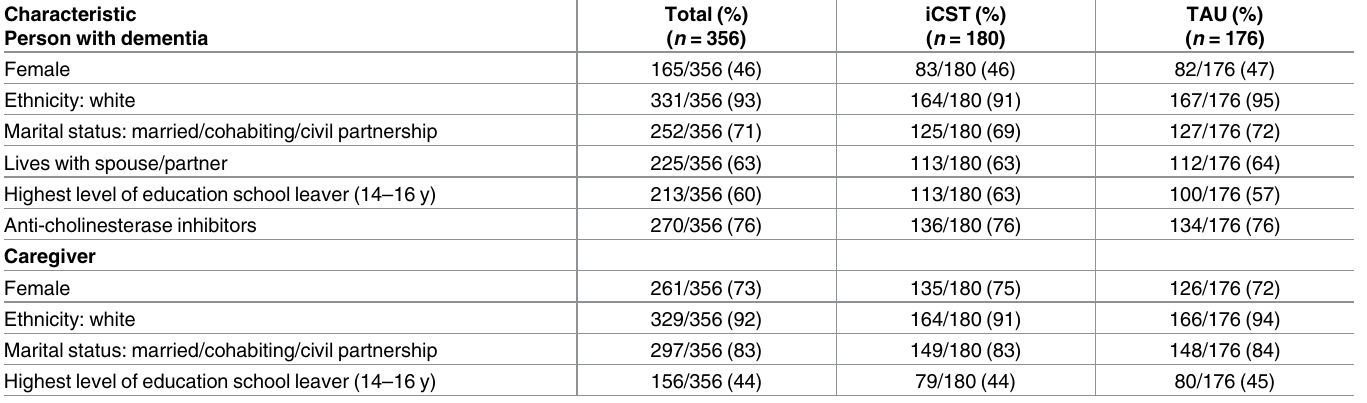
Table 1. Baseline characteristics of person with dementia and